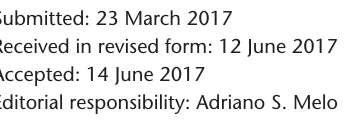
Figure S1. Species accumulation (black) and rarefaction curve (gray) based on